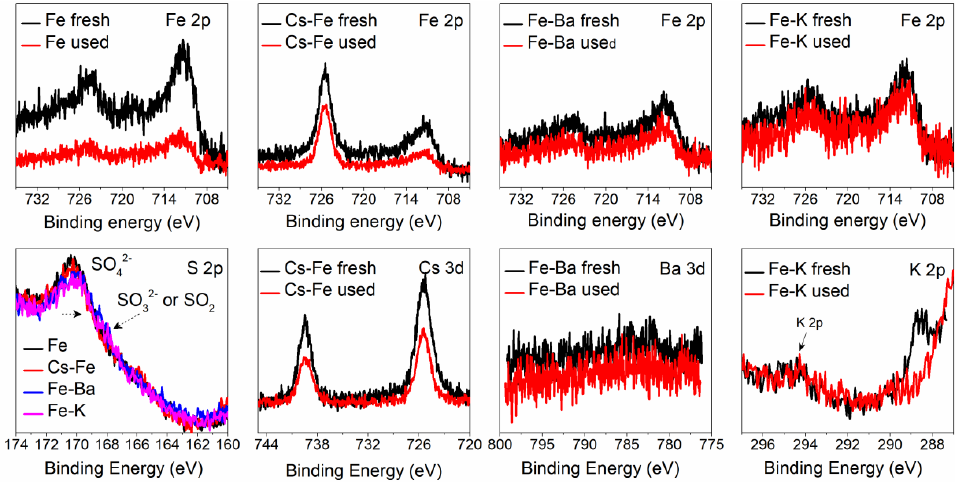
Figure 8. XPS spectra of Cs-, K- and Ba-doped Fe-HZSM-5 catalyst before and after 10 h of continu- ous reaction.